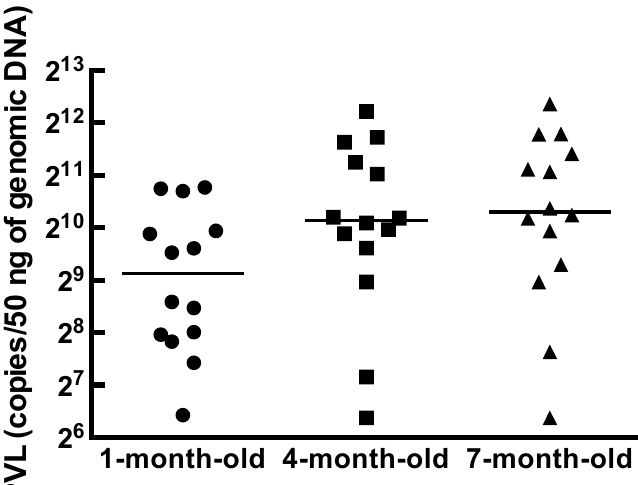
Figure 2. Changes in BLV PVLs in calves vertically infected with BLV. Bovine leukemia virus (BLV) proviral loads (PVLs) in 14 calves vertically infected with BLV were monitored at 1, 4 and 7 months old. The median PVLs at 1, 4 and 7 months old were 560, 1129 and 1269 copies/50 ng, respectively. Horizontal lines show the median values of PVLs. Significant differences were observed between PVLs at 1 and 4 months old and between 1 and 7 months old ( p < 0.05).